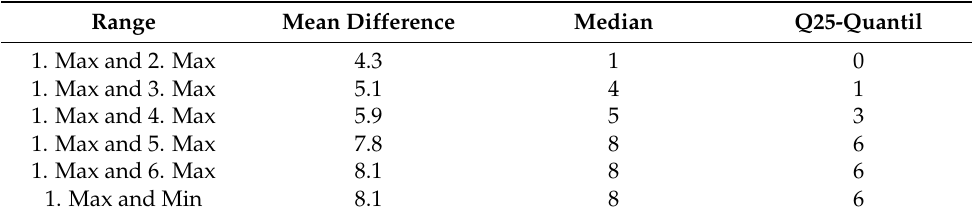
Table 6. Consideration of the delta between options using the example of the nature conservation perspective, restricted to plots where at least one option is valued higher than zero (1. Max > 0). Range Mean Difference Median Q25-Quantil